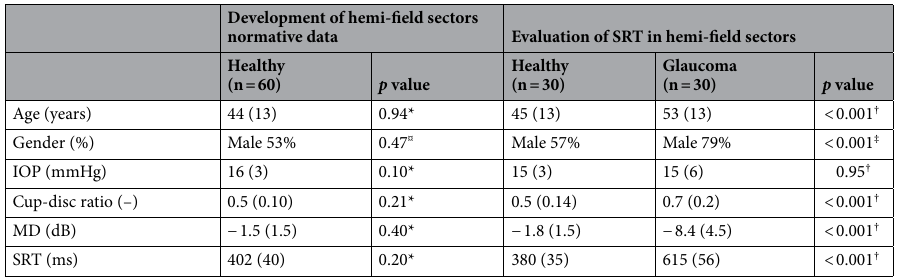
Mild glaucoma (n =